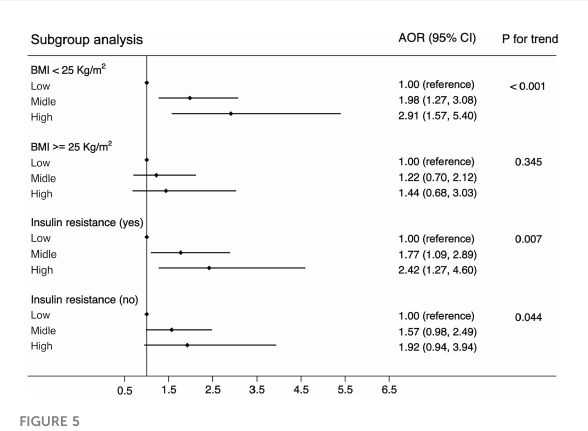
FIGURE 5 Strati fi cation analysis of the association between WBC and risk of MS. Subgroups based on BMI (<25 or >=25) or HOMA-IR (yes or no). Data are shown as OR and 95% CI.